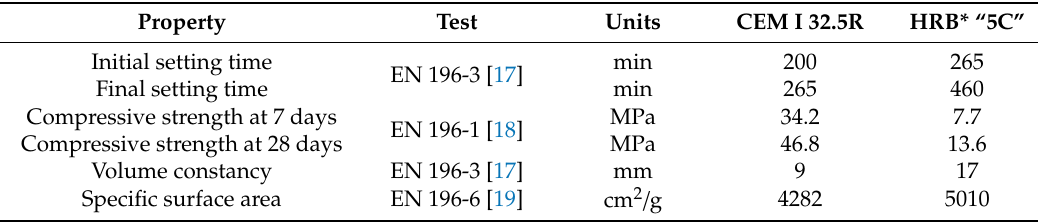
Table 3. Properties of Portland cement and hydraulic road binder “5C”.